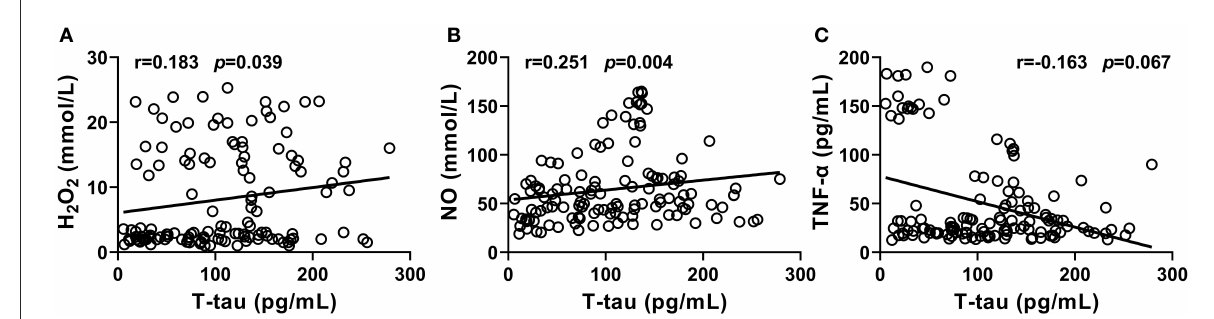
FIGURE5 (A–C) Correlations of T-tau level with the levels of free radicals and neuroinflammatory factors, and the activity of tSOD in CSF from PD-NPSs group were analyzed. The results displayed that the levels of H 2 O 2 and NO significantly and positively correlated with T-tau level in CSF from PD-NPSs group. The levels of TNF- α and T-tau in CSF showed a negative correlation with P value close to a significant